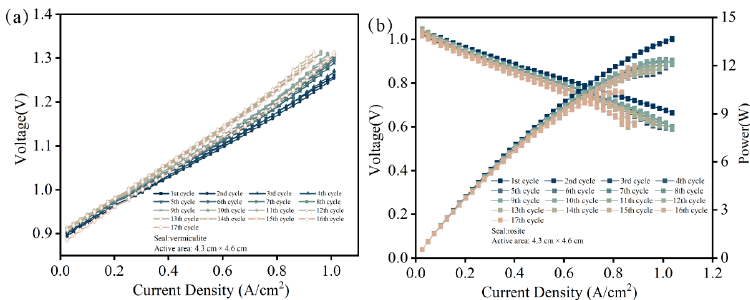
Figure 7. I–V curves in SOFC ( a ) and I-P-V curves in SOFC ( b ) of 1-cell during thermal Figure 7. I-V curves in SOFC ( a ) and I-P-V curves in SOFC ( b ) of 1-cell during thermal cycles.